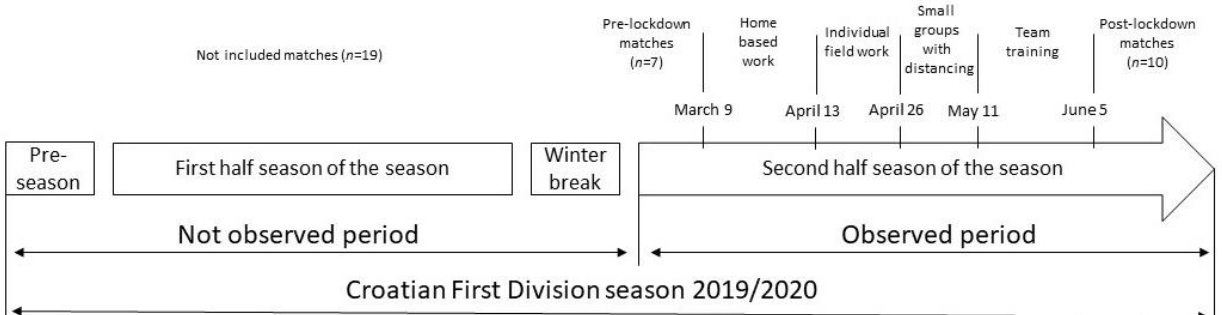
Figure 1. Timeline of the Croatian First Division 2019/2020 season.